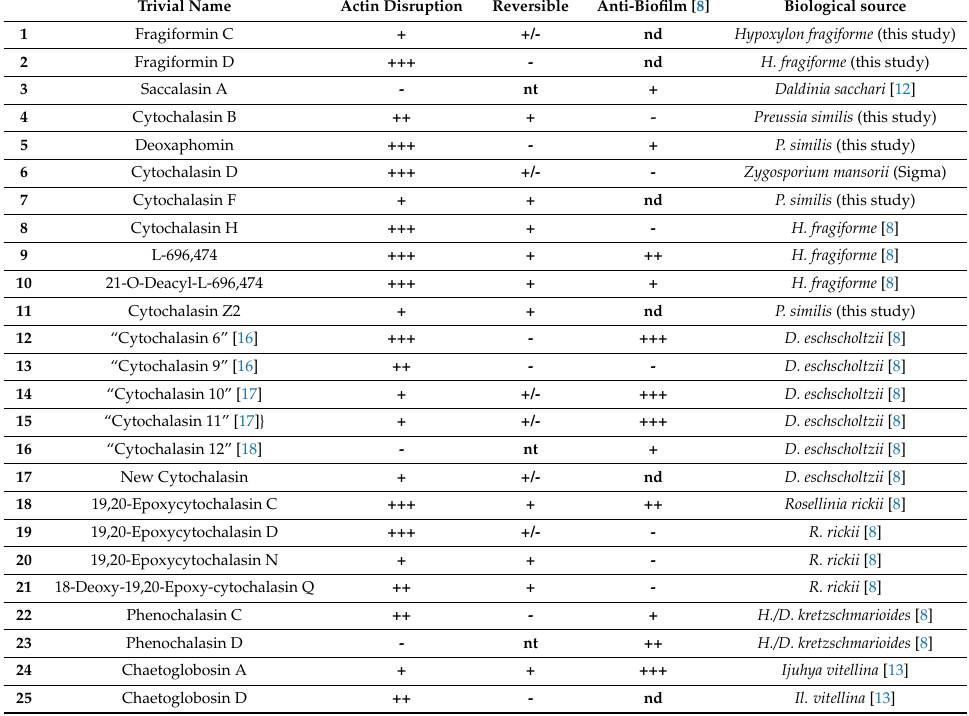
Table 2. Effects of cytochalasans on mammalian cells and against biofilms of Staphylococcus aureus . Actin disruption : +++ complete disruption at 1 µ g/mL, ++ complete disruption at 5 µ g/mL, + incomplete disruption at 5 µ g/mL, - no disruption; Reversibility: + reversible effect, +/- partially reversible effect, - irreversible; nd : not determined because it was not active in the first place. Anti-Biofilm activity : activities taken from the study by Yuyama et al. [8]; nt : compound not tested, due to insufficient amounts available or apparent